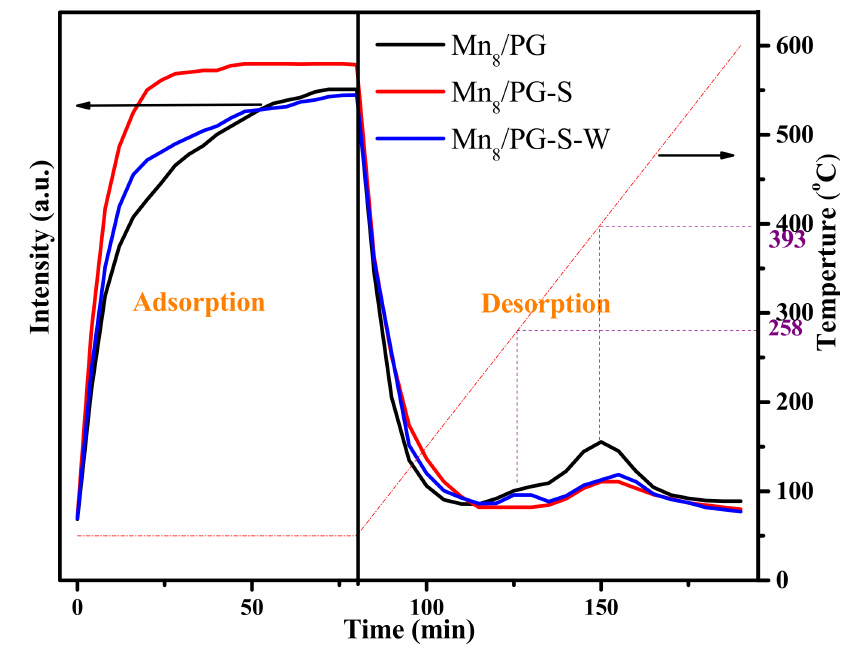
Figure 11. The NO emission profiles of isothermal adsorption and following temperature- programmed desorption (TPD). Reaction conditions: 0.5 g of the catalyst, 600 ppm of NO, GHSV = 16,000 h − 1